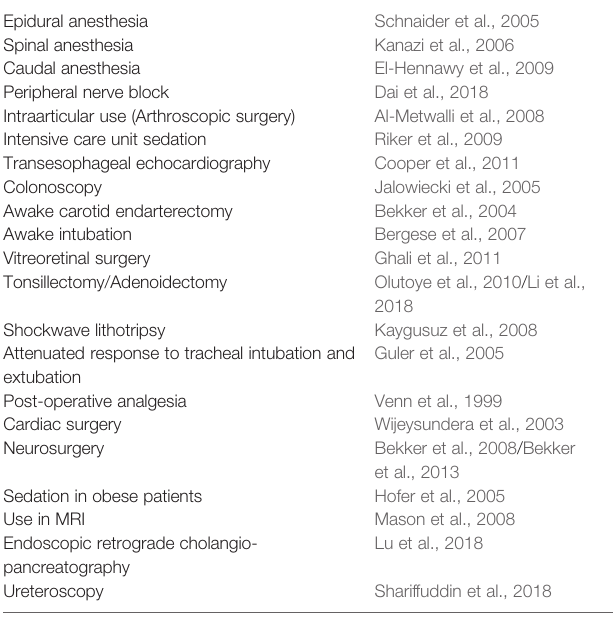
TABLE 1 | Reported use of DEX in several settings of perioperative